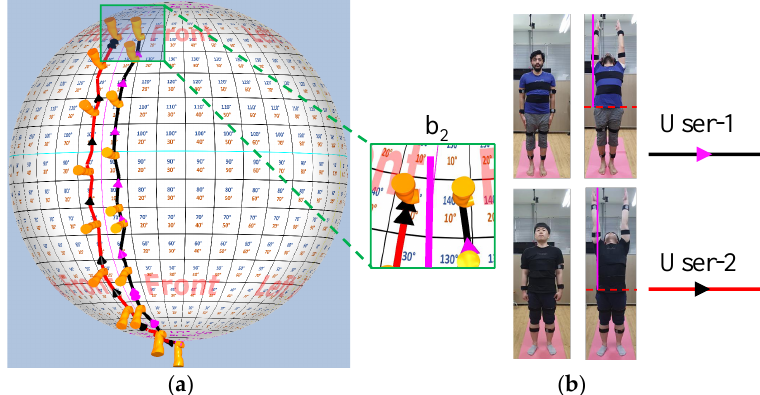
Figure 16. Comparison of human motion in multiple users’ data. ( a ) Visualization of user’s right upper arm ( b 2 ) data on the sphere. ( b ) Users performing upper arm movements.